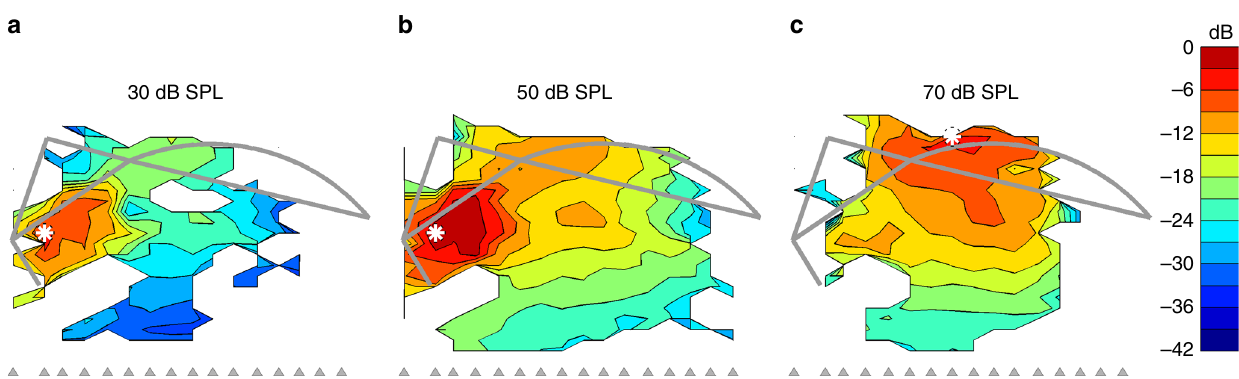
Fig. 3 Level-dependent modes of vibration near CF. Maps of vibration magnitudes evoked by the 22.6 kHz component of a multi-tone stimulus at three sound pressure levels: a 30, b 50, and c 70 dB SPL. Magnitudes are expressed in decibels relative to the 4.1-nm maximum observed at the location marked with the white asterisk in b (asterisks in a and c mark the sites of peak amplitudes at 30 and 70 dB SPL = 2.6 and 2.1 nm, respectively). Measurement beam ordinates are indicated at the base of each map using gray arrowheads. The structural framework of the organ of Corti is shown for reference in gray (cf. Figs. 1, 2). Data were obtained from the same preparation as in Fig. 2, CF 23 kHz